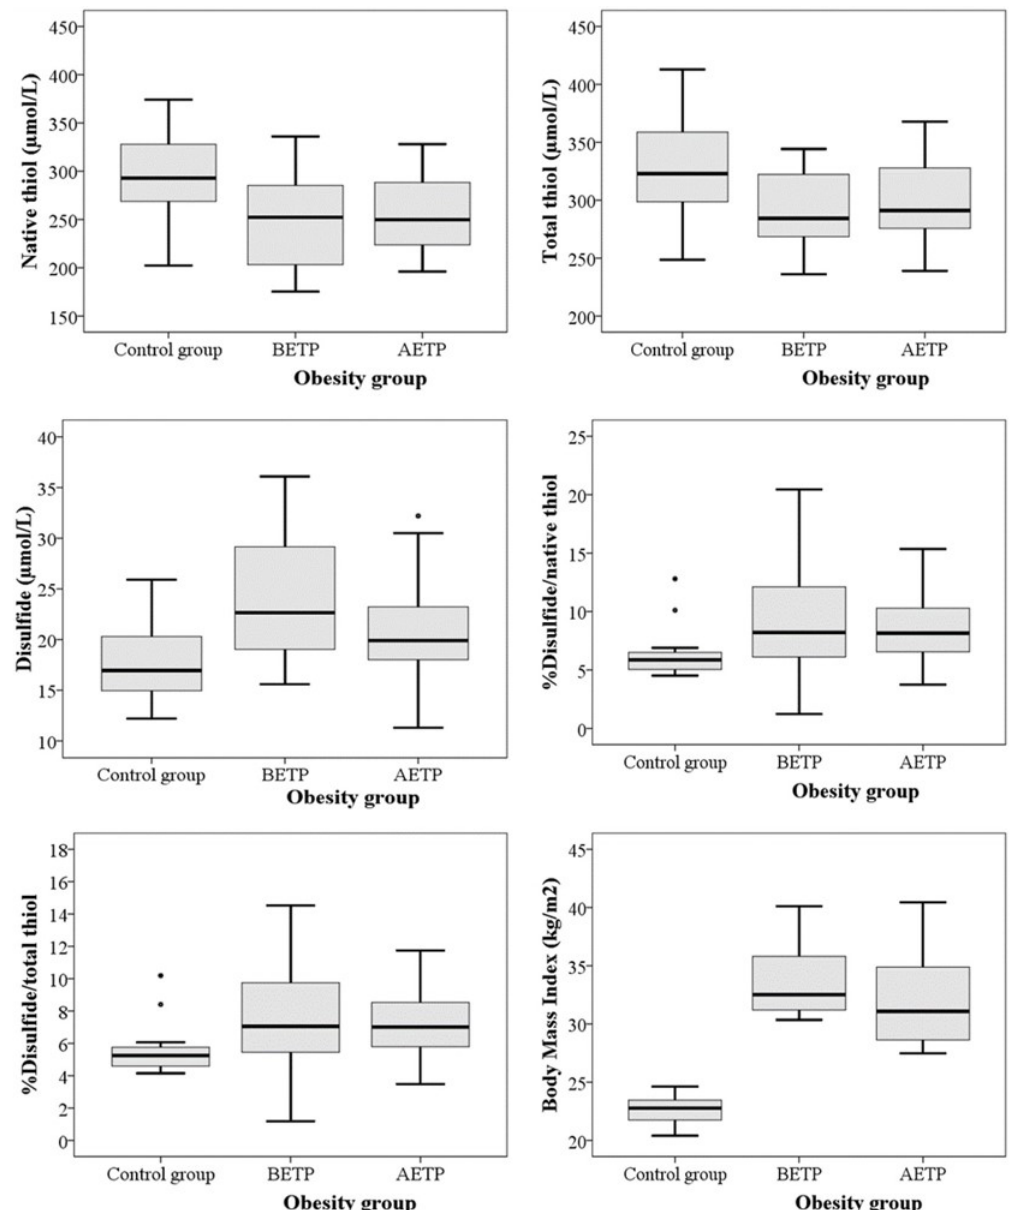
Figure 1 - the comparison of tDH and BMI parameters between the obese and control groups both prior to and after the completion of the exercise training program. BetP: before exercise training program; AetP: after exercise training